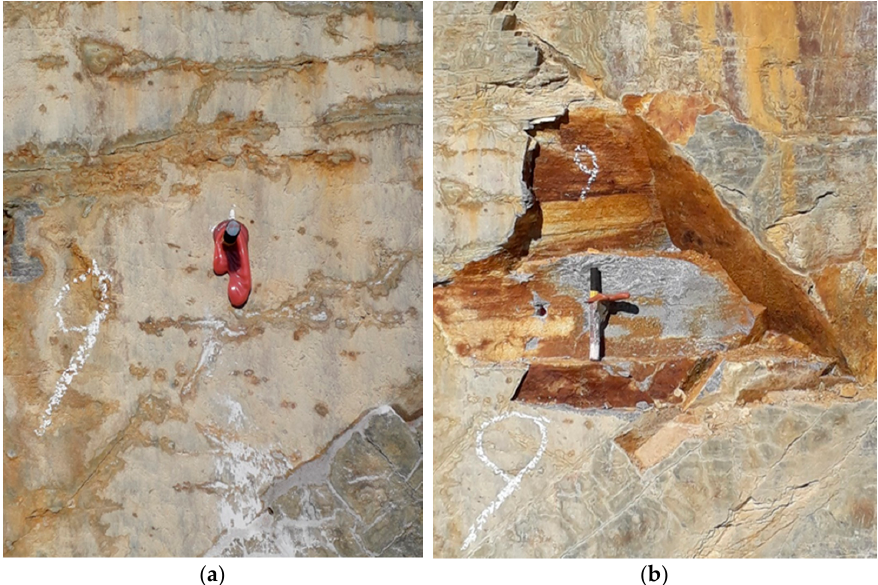
Figure 3. Joint quantity next to the anchor ( a ) before pull ‐ out test in undisturbed area–no critical joints visible and ( b ) after pull ‐ out test–critical joints visible.